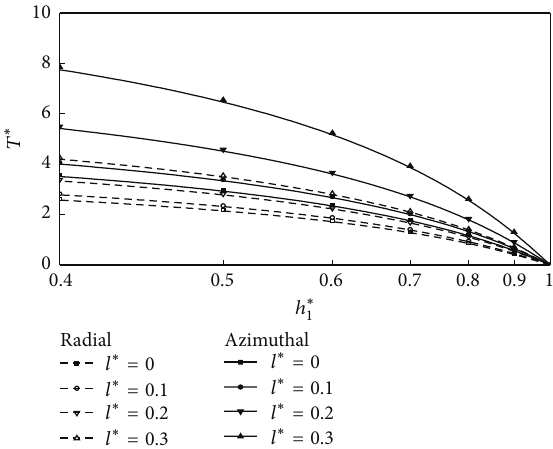
Figure 4: Variation of nondimensional load carrying capacity 𝑊 ∗ with 𝐻 ∗ for different values of 𝑀 0 with 𝑙 ∗ = 0.3 and 𝐶 = 0.3 .